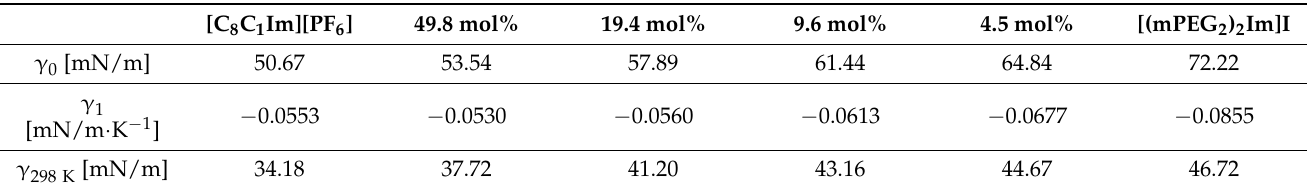
Table 1. Coefficients of the linear fits to the data according to Equation (1) for pure ILs and mixtures and ST values at 298 K.